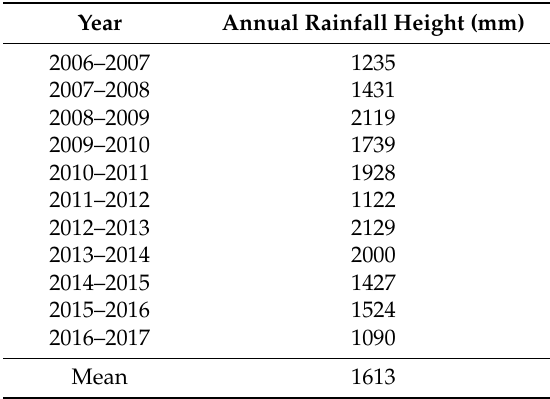
Table 5. Annual precipitations recorded by the rain gauge of Cervinara of the meteorological alert network of the Civil Protection Agency of Campania. Every year begins on 1 September and ends on 31